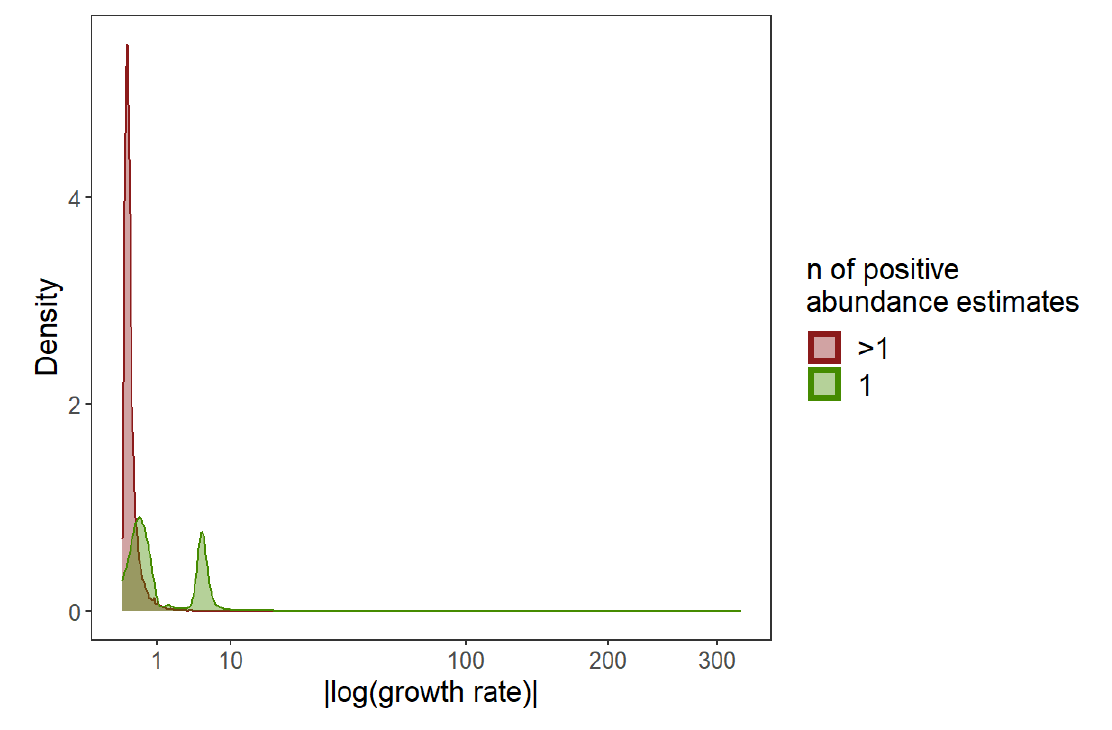
Figure S5: Truncated time series with only one non-zero yearly estimate of abundance produce extreme value of abundance trends. Density distribution of the absolute value of abundance trends, log(growth rate), as function of the number of non-zero yearly estimate of abundance contained in the truncated time series (1 vs >1). To preserve readability the x-axis is square-root